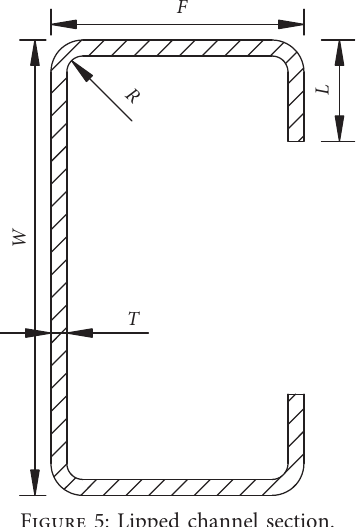
Figure 5: Lipped channel